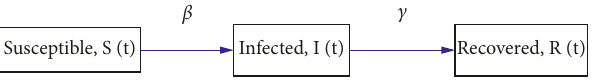
Figure 1: The SIR